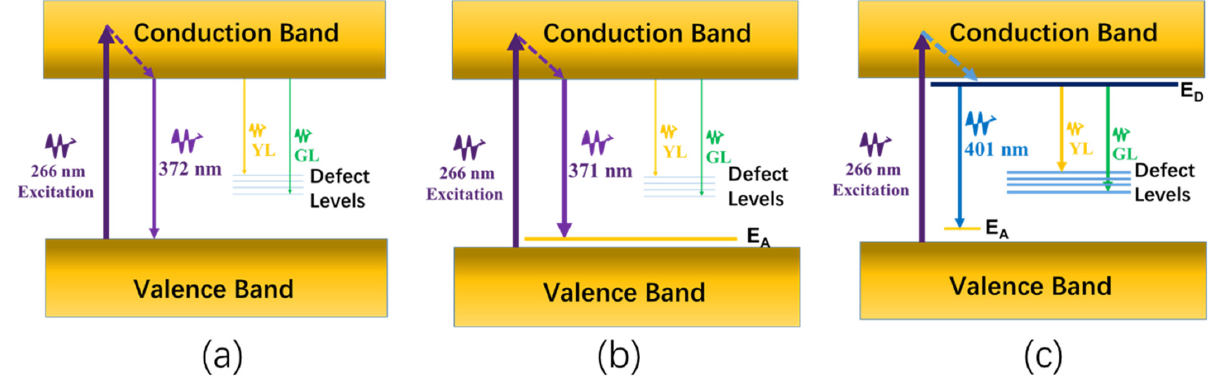
Figure 6. The energy transition diagram of the photoluminescence and lasing emission in ( a ) un- doped GaN, ( b ) Mg-doped GaN, and ( c ) Si-doped GaN thin